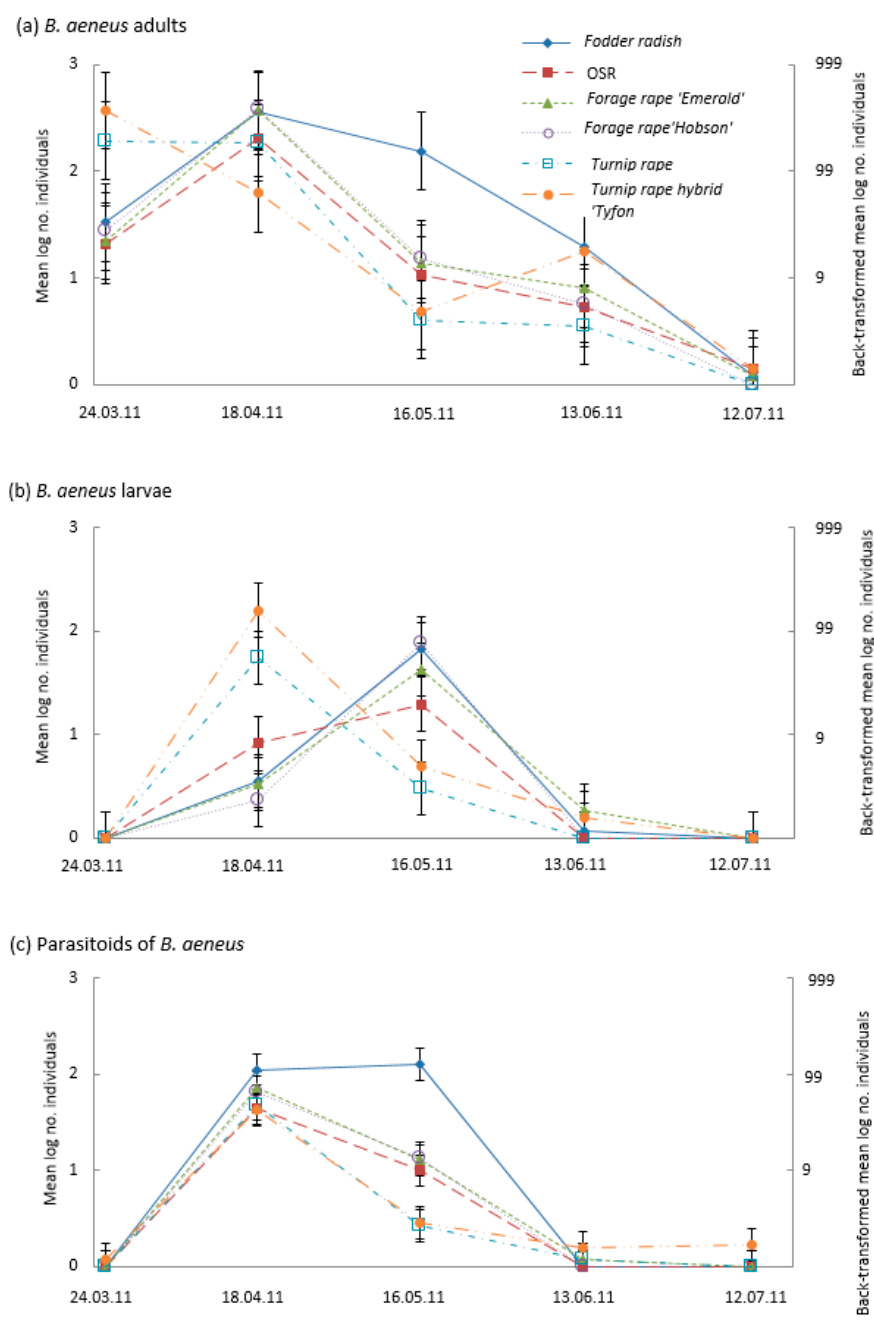
Figure 2. Mean numbers (log scale—left axis, and back-transformed -right axis) of pollen beetle ( Brassicogethes aeneus ) ( a ) adults, ( b ) larvae and ( c ) parasitoids in suction samples taken on five different dates from plots ( n = 4) of different Brassicaceae: Fodder radish ( Raphanus sativus ) cv Apoll; Oilseed rape (OSR, Brassica napus ) cv Castille; Forage rape ( Brassica napus ) cv Emerald and cv Hobson; Turnip rape ( Brassica rapa ) cv Jupiter and Tyfon (a hybrid of B. rapa Rapifer group × B. rapa Pekinensis group). Confidence intervals (CIs; vertical bars) are valid for within-date comparisons; for between-date comparisons, CIs should be based on SEM values of ( a ) 0.1711, ( b ) 0.1219 and ( c ) 0.0827.